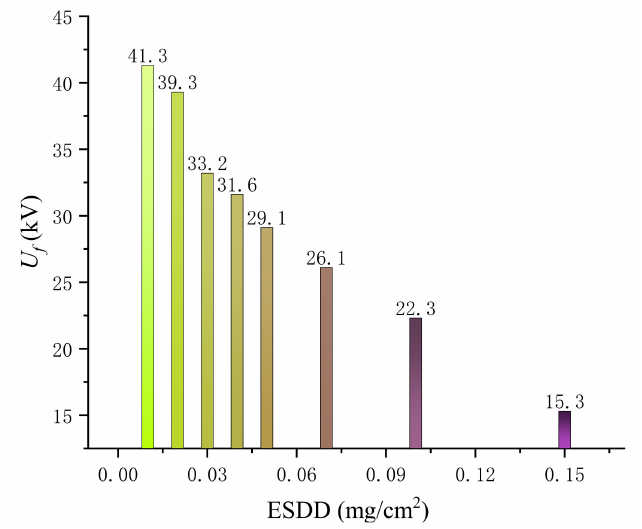
Figure 9. AC flashover test